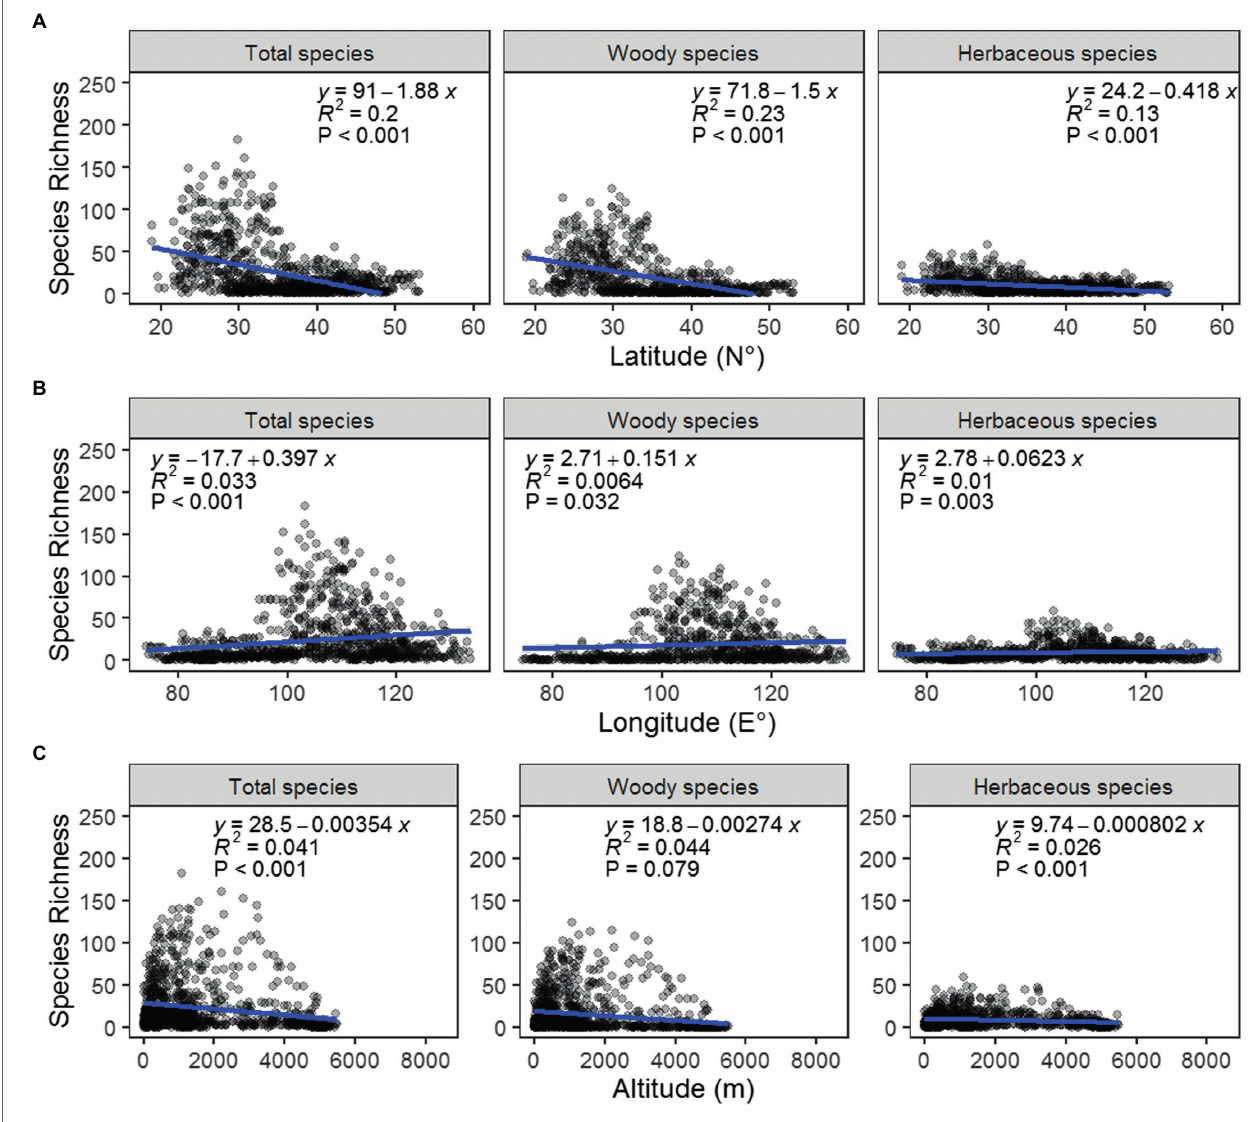
FIGURE 2 | Regression analysis between the richness of total (left), woody (middle), and herbaceous (right) samara species and latitude (A) , longitude (B) , and altitude (C)